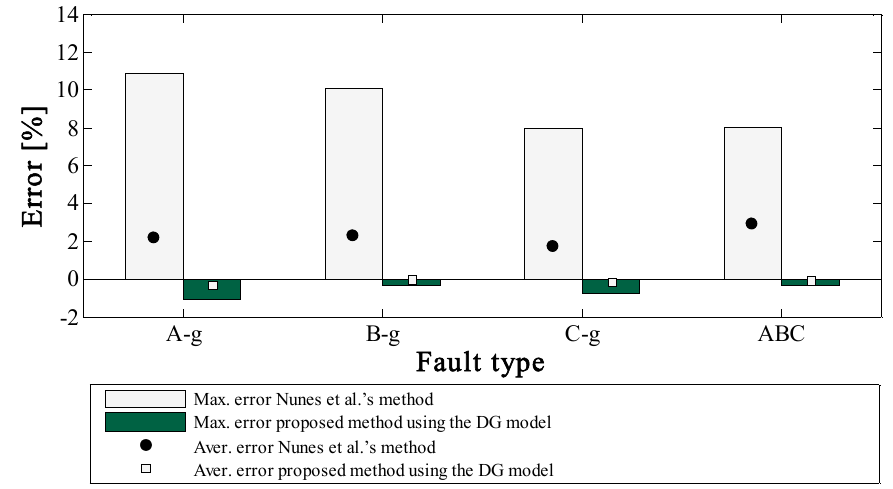
Figure 15. Fault error comparison: Nunes et al.’s method [16,17] and the proposed formulation using the electrical model of the DER. DG: distributed generation.